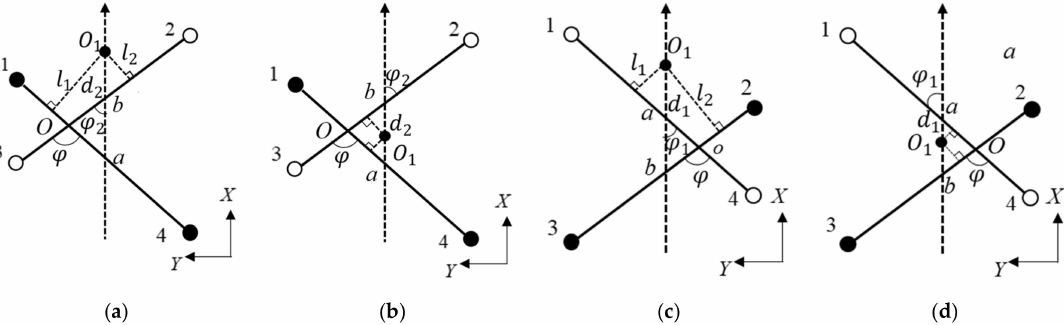
Figure 6. Four cases of gravity center distribution. In ( a ), the gravity center is before the 2–3 diagonal. In ( b ), the gravity center is behind the 2–3 diagonal. In ( c ), the gravity center is before the 1–4 diagonal. In ( d ), the gravity center is behind the 1–4